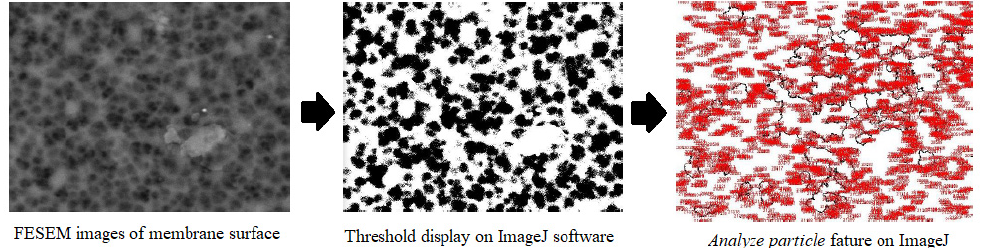
Figure 6. Pore size and surface porosity analysis using ImageJ.